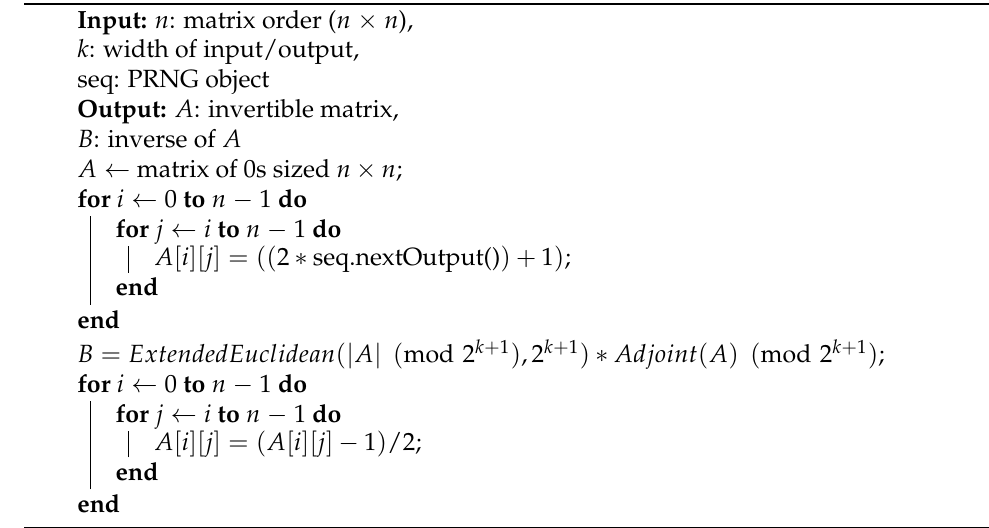
Algorithm 1: InvertibleMatrixGF( n , k , seq)—algorithm for generating an invert- ible matrix under a Galois